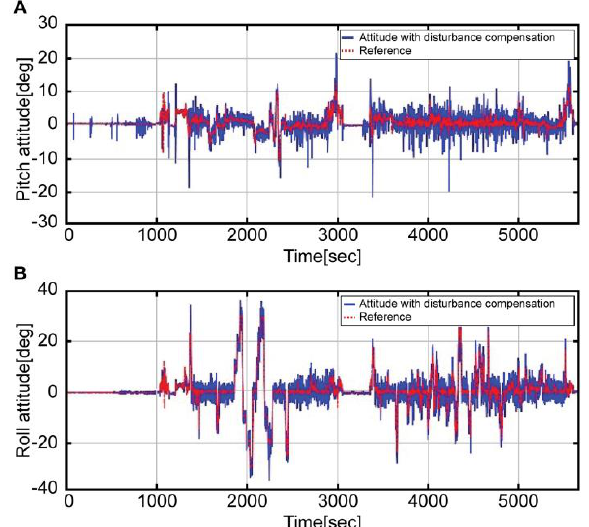
Figure 8. Attitude with compensation by the accelerometer (blue solid line) and Reference attitude (red dotted line); A: Pitch attitude, B: Roll attitude.